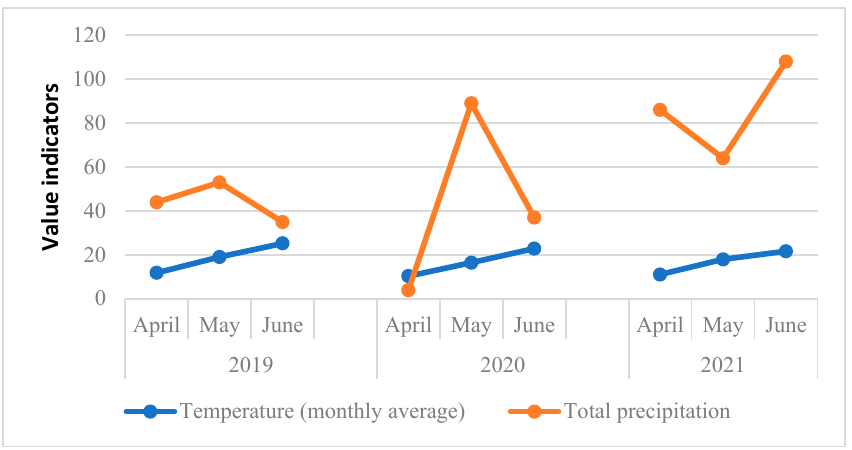
Figure 3. Average monthly air temperatures and total precipitation in 2019–2021 during the study period